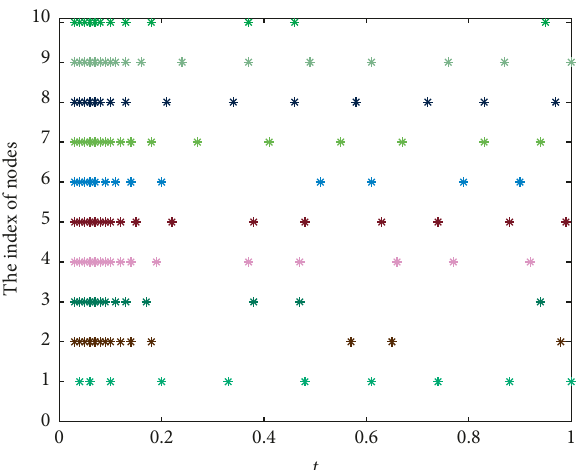
Figure 7: The events of each node with θ